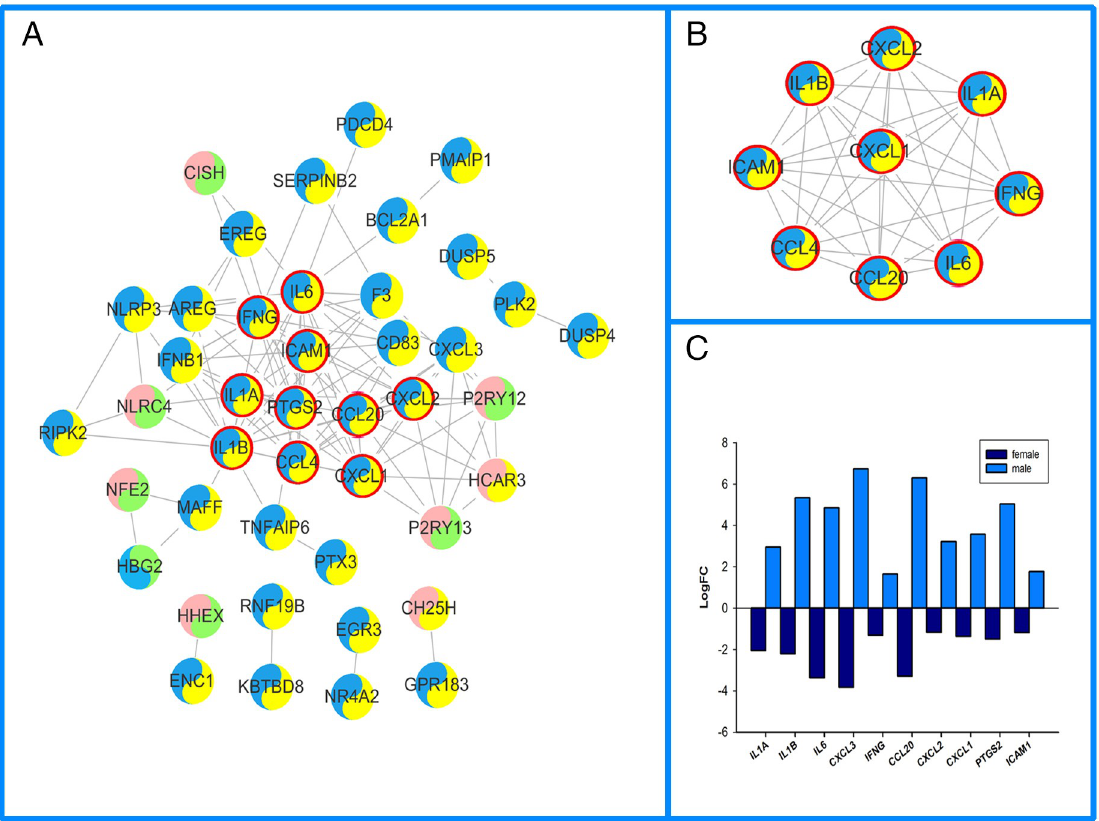
Fig 4. Female and male overlapping PPI networks in IS. A. Coregulated DEGs were shown in a tow color circle. Pink represents upregulated DEGs in females, blue represents downregulated DEGs in females, yellow stands upregulated DEGs in males, green represents downregulated DEGs in males; thicker red border emphasizes CytoNCA topologically significant DEGs. B. MCODE cluster of PPI networks. C. Top 10 CytoNCA significant DEGs.